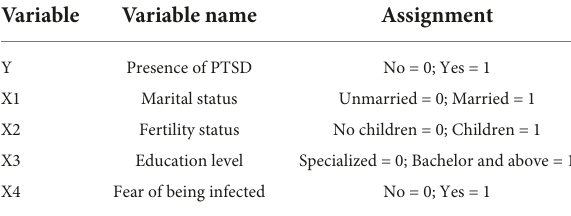
TABLE 3 Table of independent variable assignments.